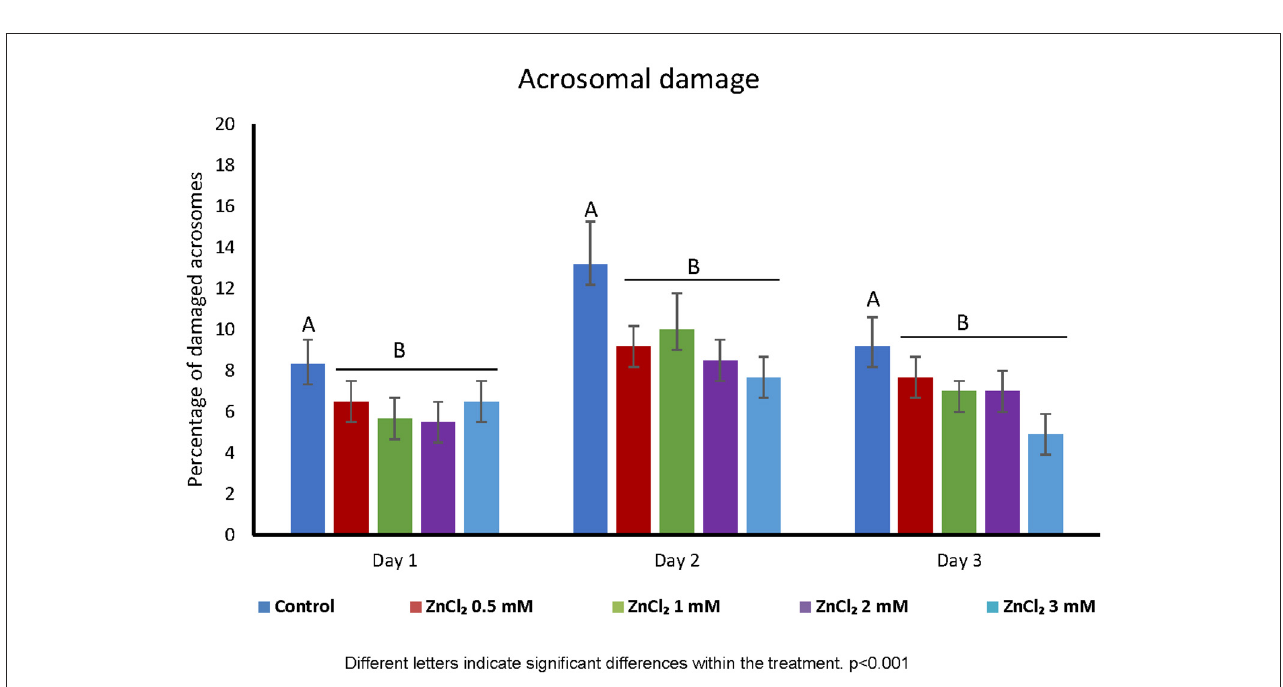
FIGURE2 Acrosome integrity. Percentage of damaged acrosomes in sperm diluted with extender containing ZnCl 2 . Acrosomal integrity was evaluated by Wells-Awa technique in seminal doses supplemented with the indicated amounts of ZnCl 2 during 1, 2, and 3 days. Letters indicate significant differences between treatments. p < 0.001; ( n =